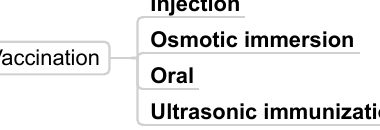
Figure 5. Partial taxonomy: